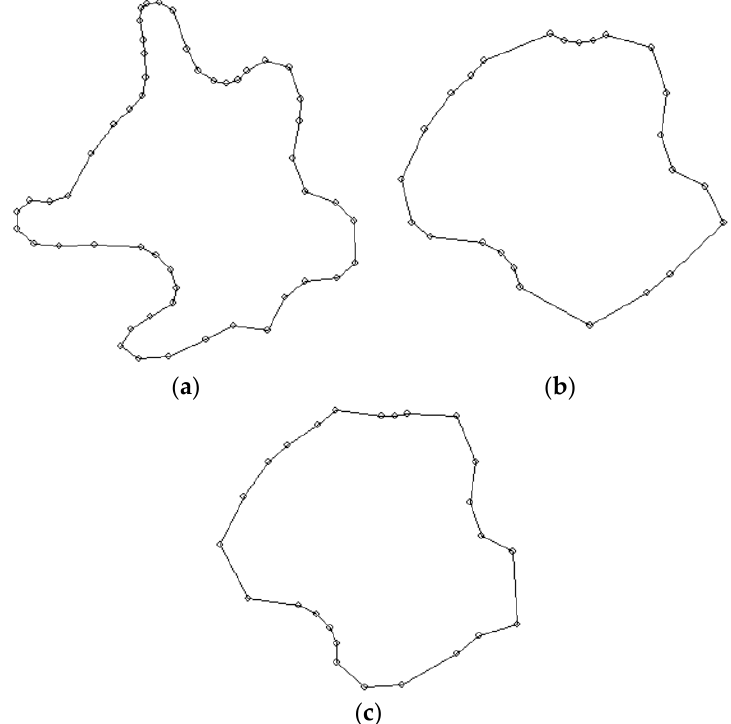
Figure 8. ( a ) Area limited by a polygon, number of vertices—52; ( b ) Area limited by a polygon, number of vertices—25, radius of generalization (modal value × MSCF )—42 m × 1.6 = 67 m; ( c ) Area limited by a polygon, number of vertices—19, radius of generalization (modal value × MSCF )—44 m × 1.6 = 70 m. Another example of closed vector line generalization is the shape that is presented in Figure 9a,b.